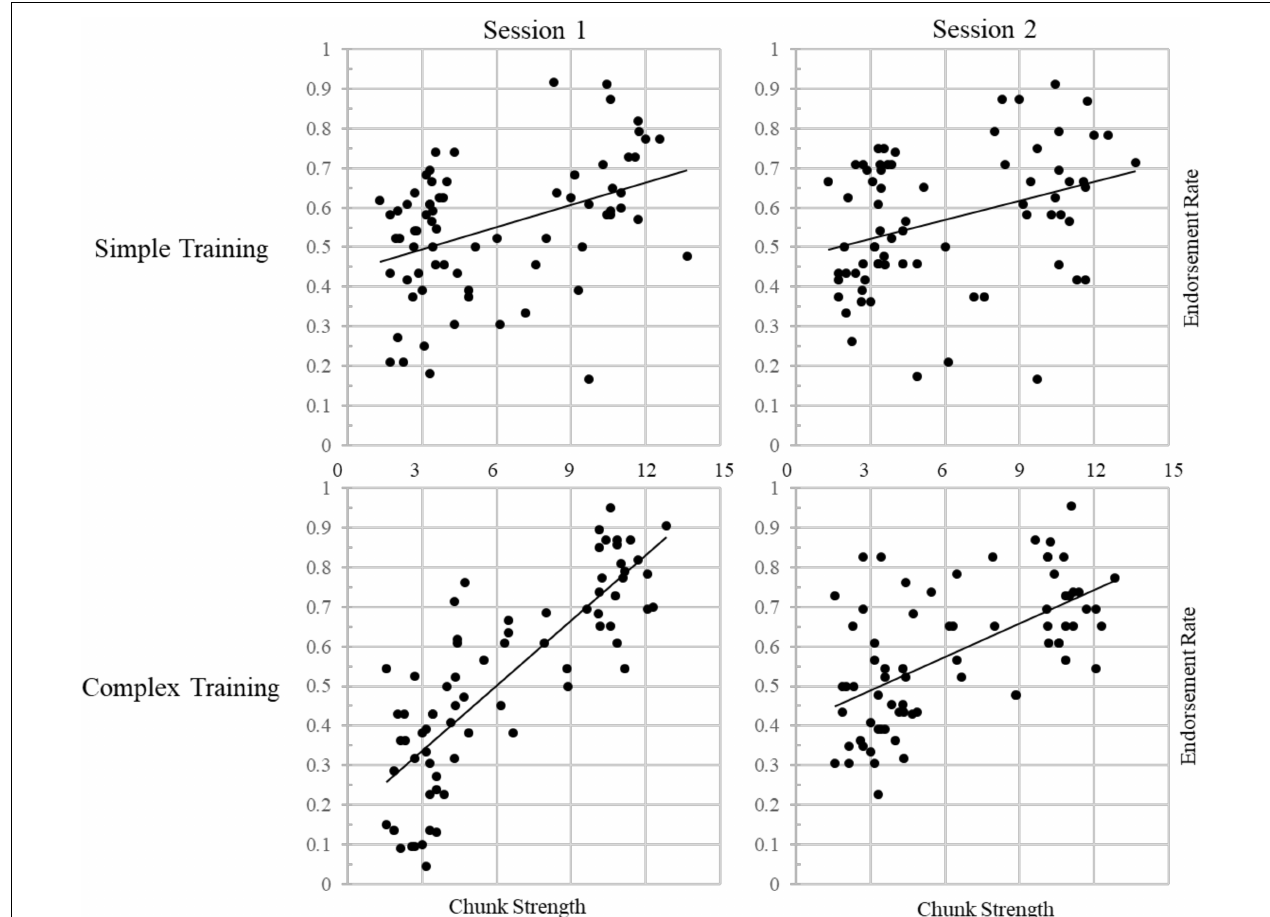
FIGURE 4 | Endorsement rates correlated with chunk strength across sessions for each training group, illustrating the three-way interaction effect in Model 3. Trend lines represents linear lines of best